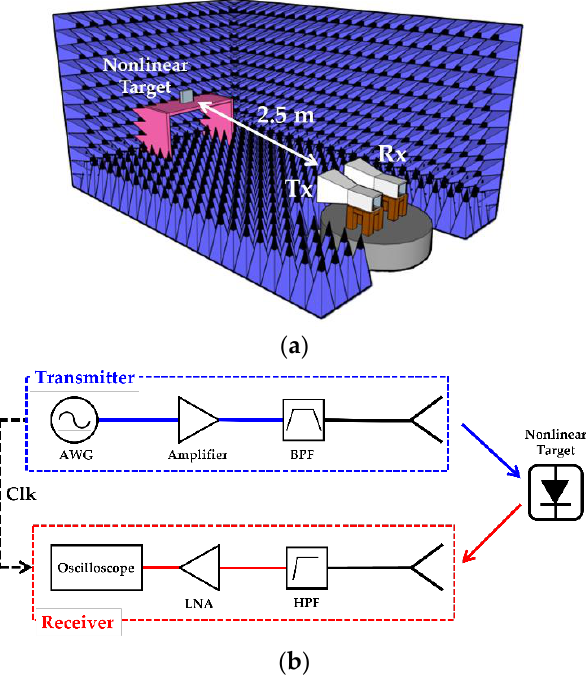
Figure 6. Nonlinear FMCW radar measurement setup: ( a ) Measurement environment in anechoic chamber and ( b ) block diagram of setup.